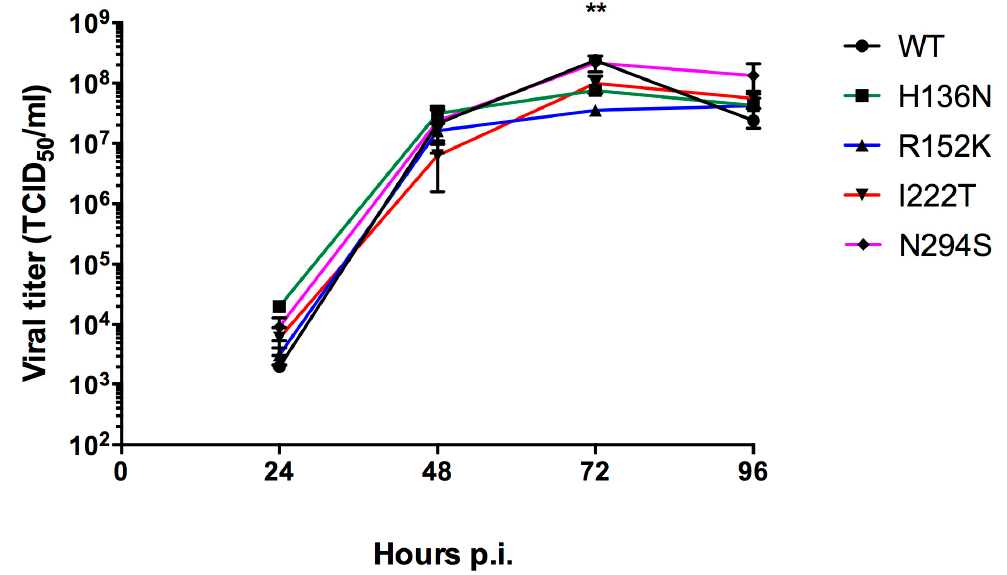
Figure 1. Replicative capacity of recombinant influenza B/Phuket/3073/2013 viruses in STG6GalI-MDCK cells. Cells were infected with a MOI = 0.0001 in triplicate for each group and viruses were harvested at 24, 48, 72 and 96 h p.i. and frozen at − 80 ◦ C before viral titration by TCID 50 . **, p < 0.01 between WT and R152K groups using one-way ANOVA Dunnett’s multiple comparisons of each mutant relative to the WT virus.